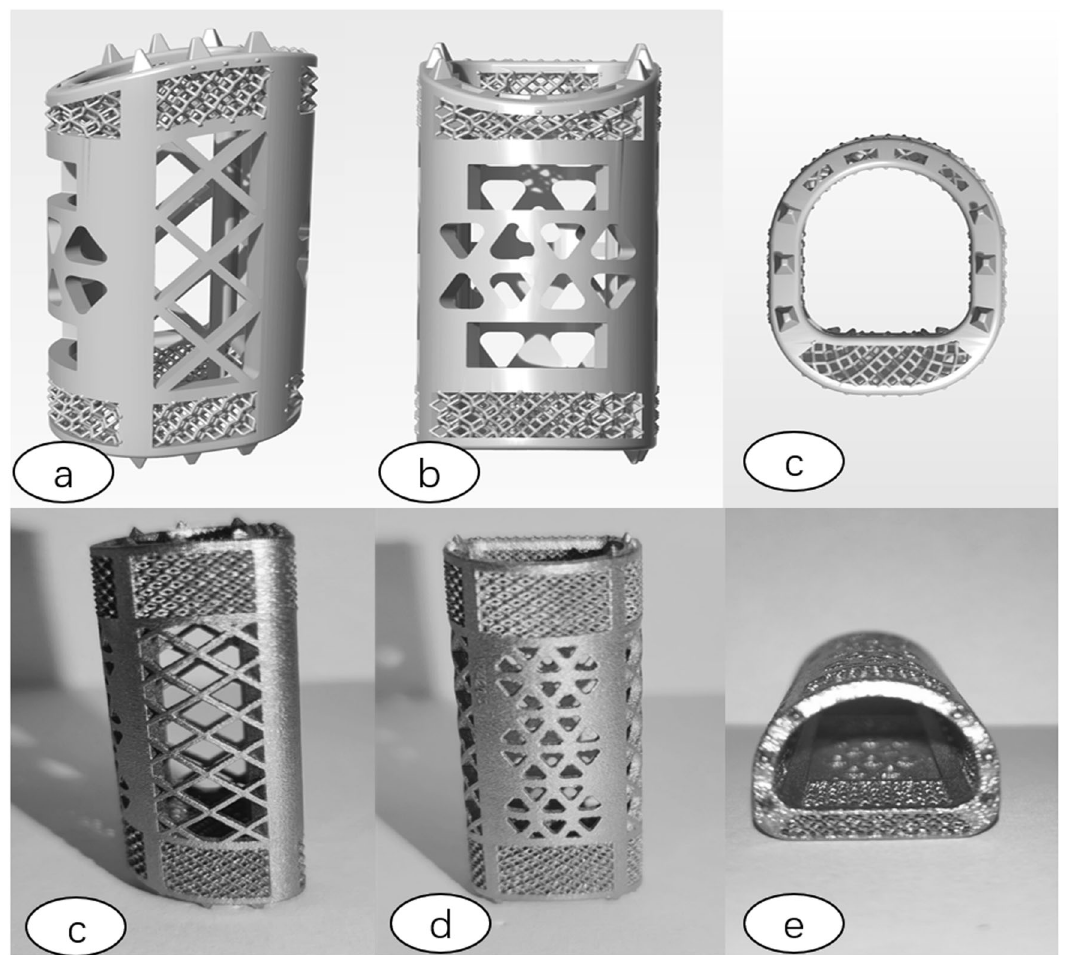
Fig. 2 Bionic 3D printing porous titanium alloy bracket Schematic and physical drawings (( a ) 3D three-dimensional side view ( b ) 3D three- dimensional front view ( c ) 3D three-dimensional top view ( d ) 3D